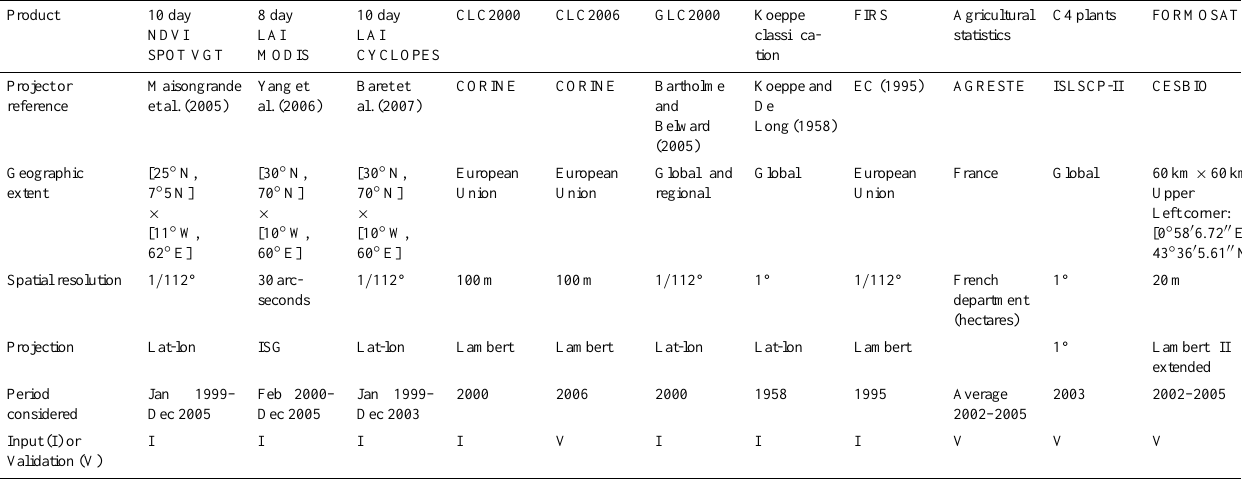
Table 1. Summary of the main characteristics of the data used in this study.